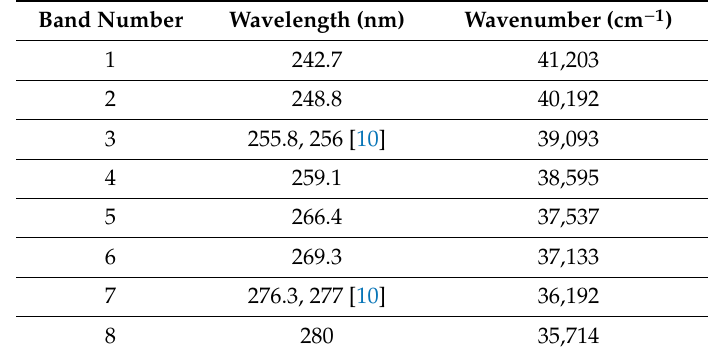
Table 1. Positions of the observed photoionization